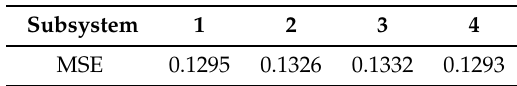
Table 2. Mean value of mean square error (MSE) for each subsystem.